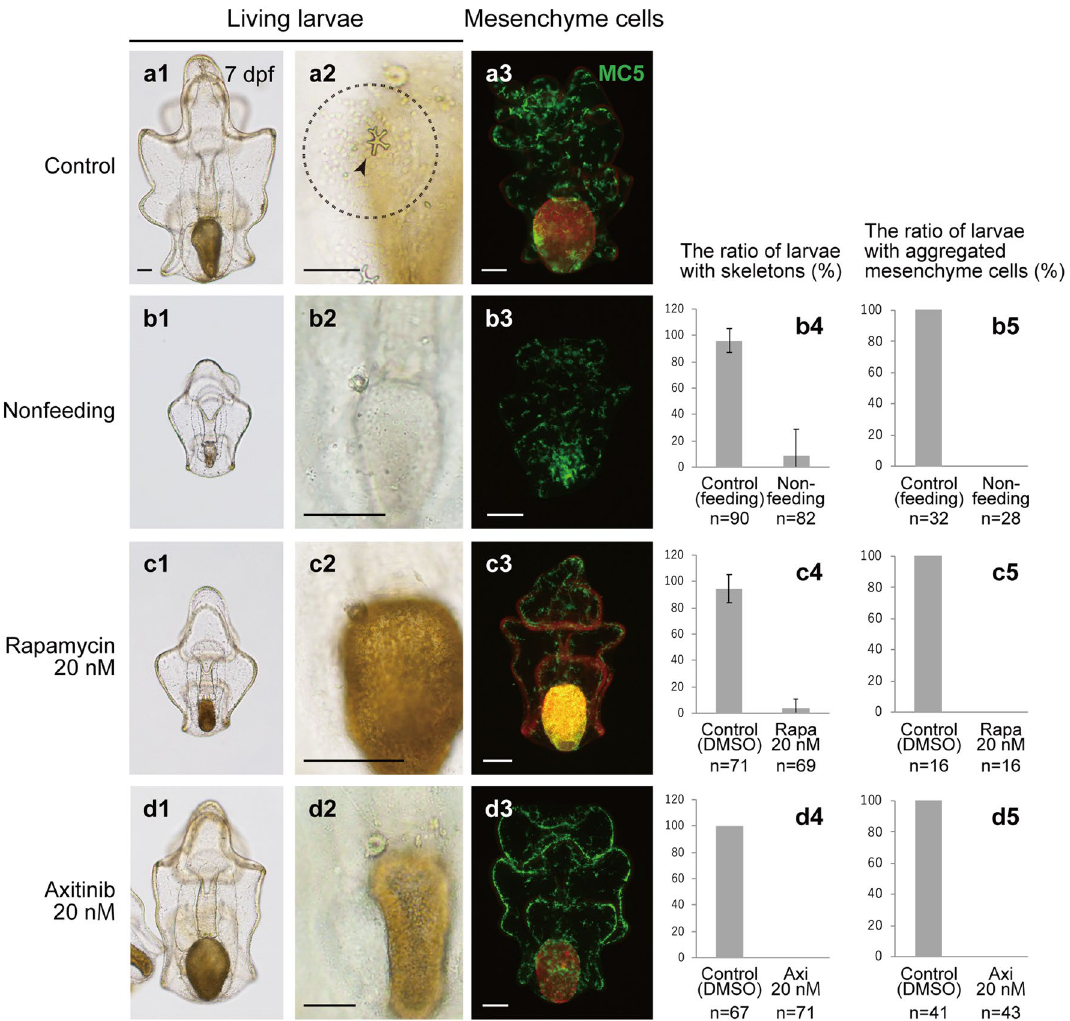
Figure 3. Observations of skeleton formation in the experimental starfish larvae. Morphology and skeleton formation were observed in control larvae ( a1 – a3 ), nonfeeding larvae ( b1 – b5 ), rapamycin (rapa)-treated larvae ( c1 – c5 ), and axitinib (axi)-treated larvae ( d1 – d5 ) at 7 dpf. ( a1 – d1 , a2 – d2 ) Living larvae. In the panel a2, the arrowhead indicates an adult skeletal rudiment and the dotted circle indicates aggregated mesenchyme cells. ( a3 – d3 ) Fluorescence images of larvae examined by immunohistochemistry using the mesenchyme-specific marker MC5. The green signal shows MC5 expression, whereas the red signal shows Chaetoceros calcitrans in the stomach or autofluorescence. At 7 pdf, the ratio of larvae with adult skeletons ( b4 – d4 ) and that of larvae with aggregated mesenchyme cells in the posterior dorsal region ( b5 – d5 ) were evaluated. Feeding larvae and DMSO-treated larvae were used as controls for nonfeeding larvae and inhibitor-treated larvae, respectively. Scale bars: 50 μm. M: